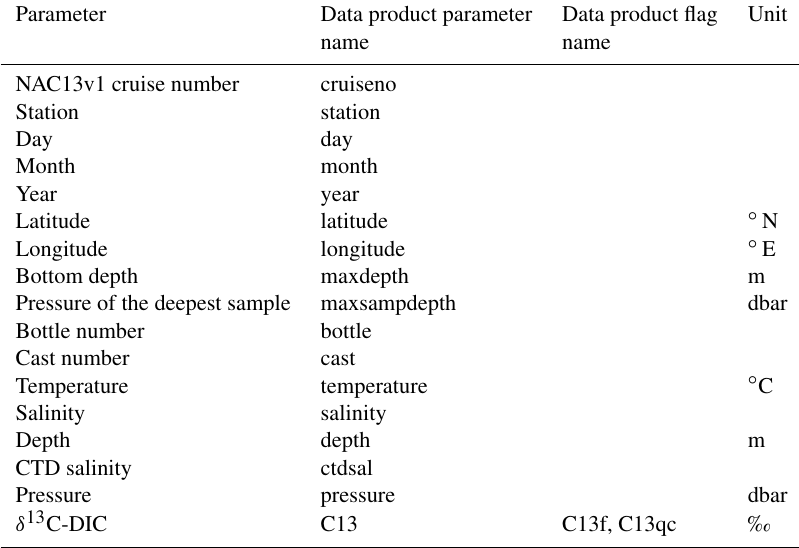
Table 3. NAC13v1 dataset parameter list, column names used in the data product, and the respective